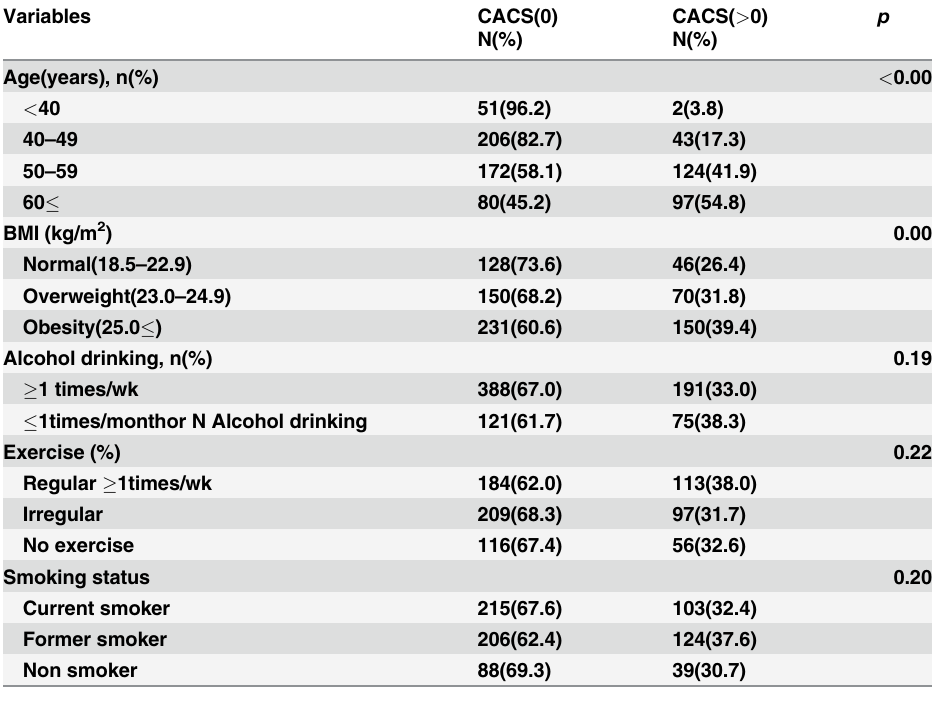
Table 1. Baseline Characteristics of study